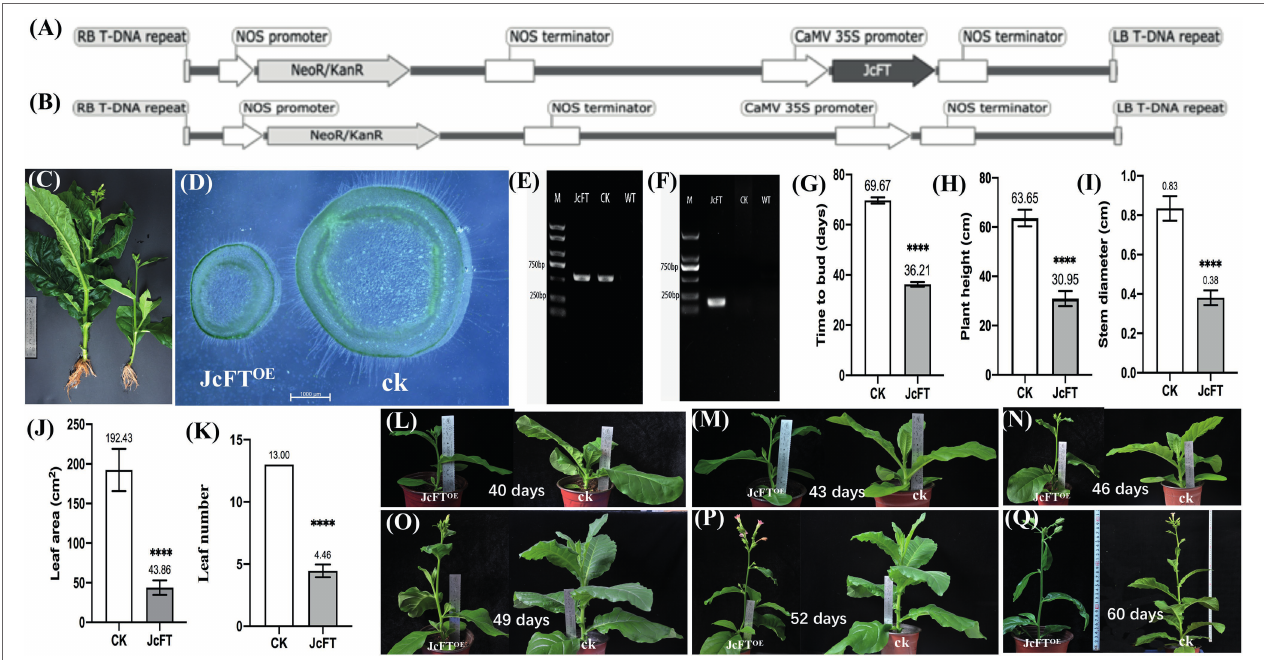
FIGURE 1 | Traits of JcFT OE transgenic and control plants. T-DNA of transformation vectors of (A) JcFT OE and (B) the control. (C) Roots, plant height, leaf, stem thickness, and leaf number of JcFT OE and control (CK) plants. (D) Stem cross sections of JcFT OE and control plants. (E,F) Gel electrophoresis of PCR-amplified products used to identify transgenic tobacco (O, PCR amplification of NPTII ; P, PCR amplification of JcFT ). (G–K) Flowering time, plant height, stem diameter, leaf area and leaf number of JcFT OE and control plants (the values represent mean, the vertical bars indicate standard deviation, n = 24, **** p < 0.0001). (L–Q) Different growth stages of JcFT OE and control plants. Sampling from 43 to 49 days after